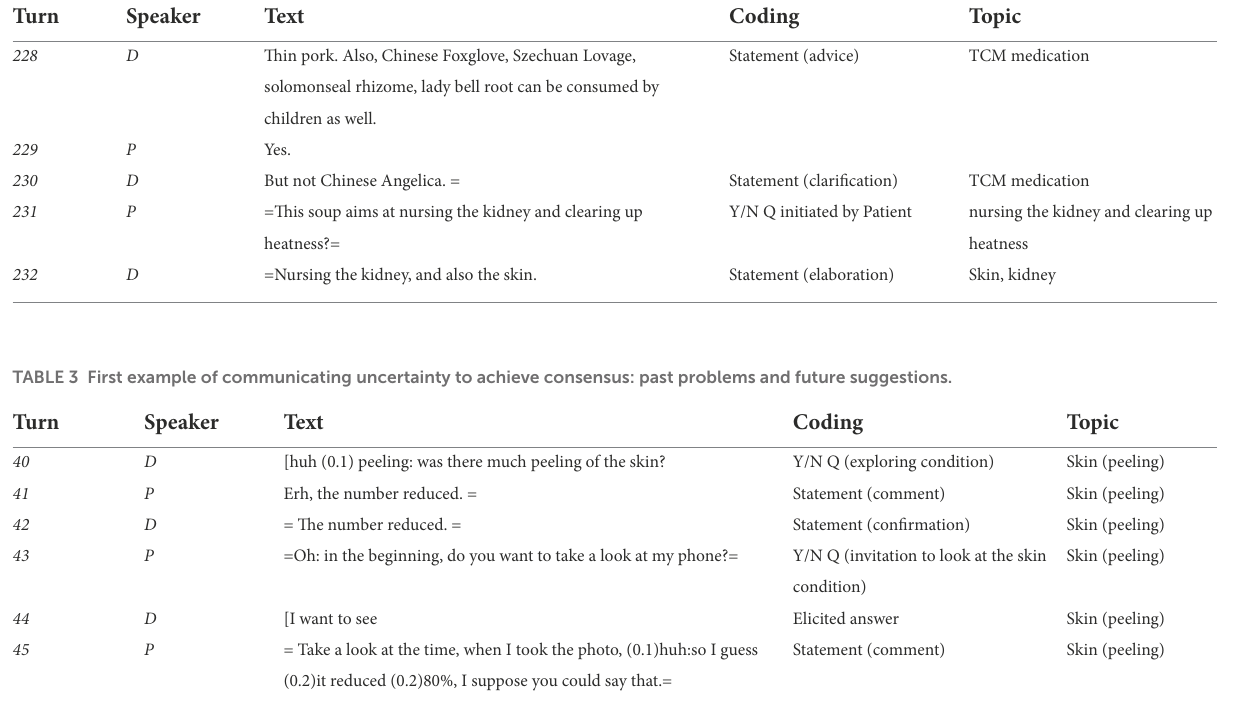
TABLE 2 Example of defining uncertainty in collaborative decision-making.